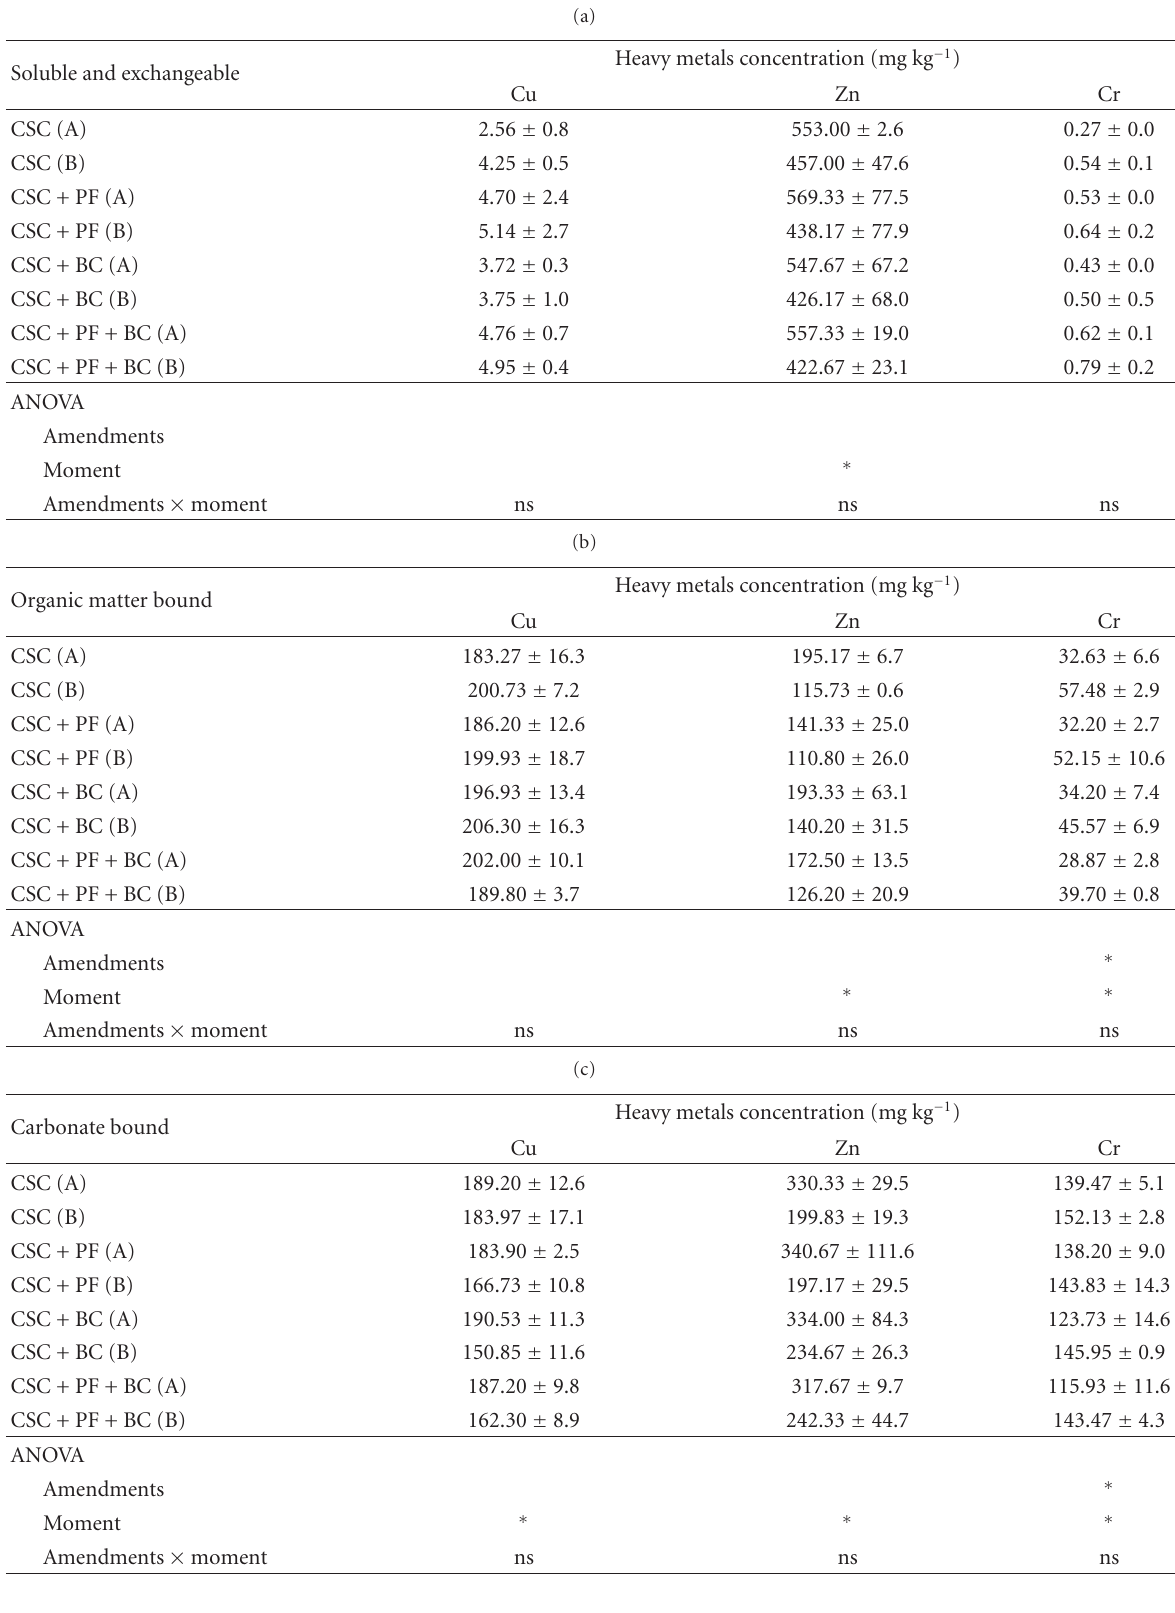
Table 5: Distribution of copper (a), zinc (b), and chromium (c) in soil chemical fractions at two time points of the experiment: beginning (A) and end (B). Treatments: CSC: Contaminated Soil, CSC + PF: Contaminated Soil + Phosphate Fertilizer, CSC + BC: Contaminated